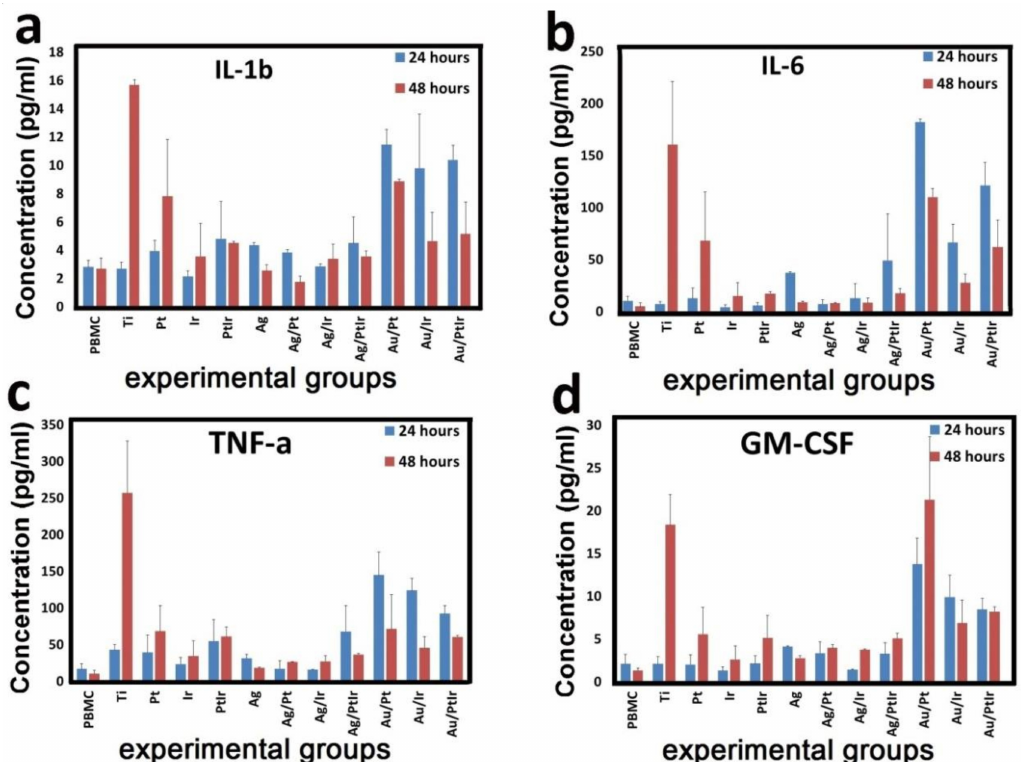
Figure 8. Concentration of dissolved cytokines IL-1b ( a ), IL-6 ( b ), TNF-a ( c ), and GM-CSF ( d ) in the culture medium after cocultivation with PBMCs and a series of experimental samples for 24 and 48